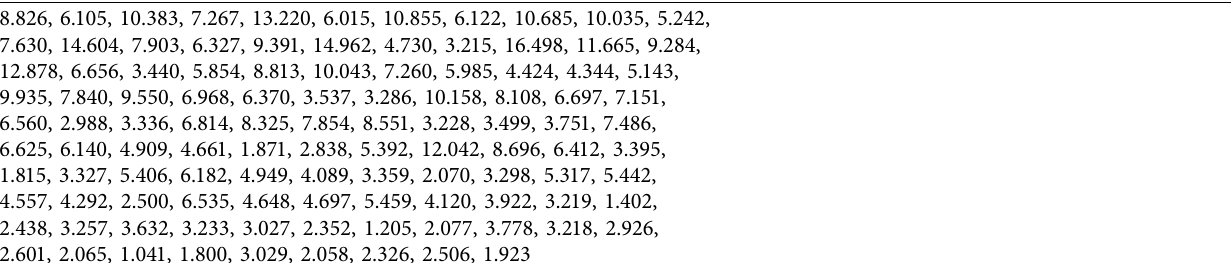
Table 10: COVID-19 fatality rate data set.